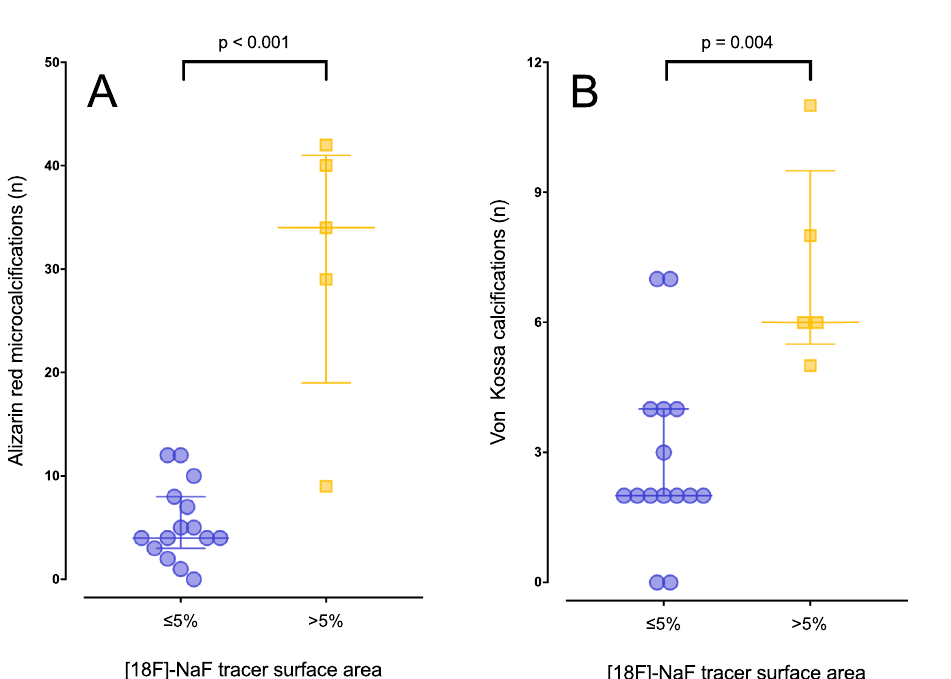
Figure 4. Differences between two groups, ≤ 5% and > 5% [ 18 F]-sodium fluoride ([ 18 F]-NaF) tracer surface area, for the number of Alizarin red stained microcalcifications ( A ) and Von Kossa stained calcifications ( B ) (median, interquartile